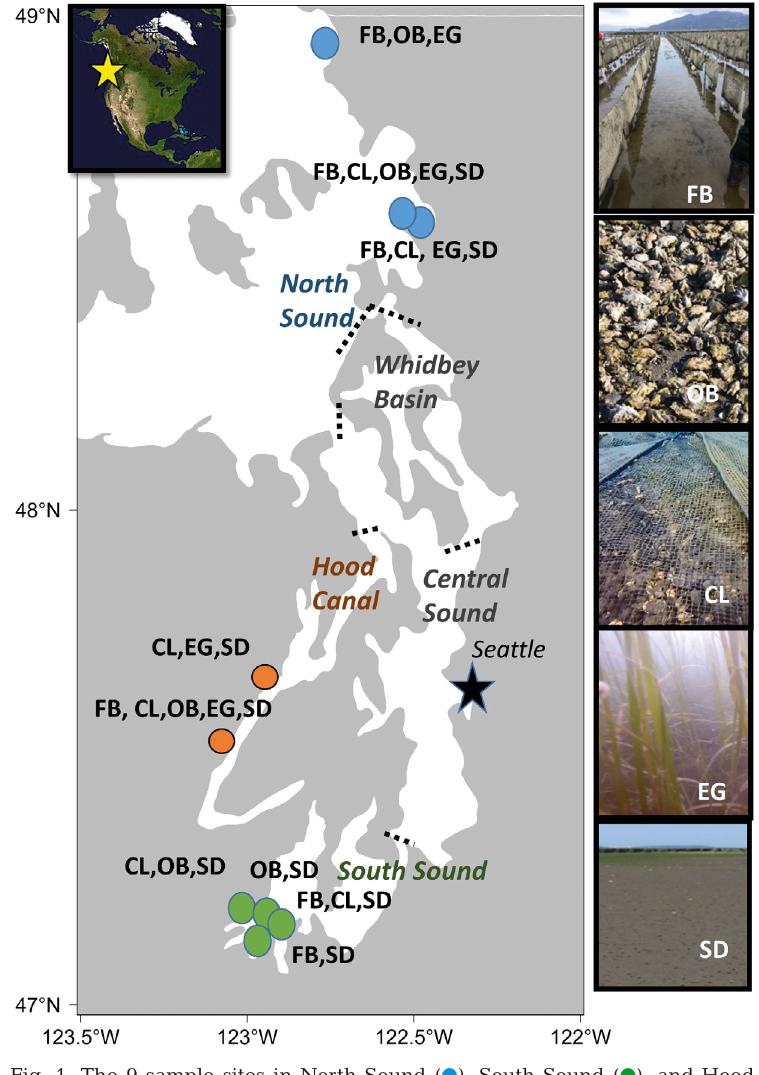
Fig. 1. The 9 sample sites in North Sound ( d ), South Sound ( d ), and Hood Canal ( d ), Puget Sound, Washington, USA. The 5 natural basins are labelled with their boundaries marked by dashed black lines. Photos show the 5 meso- habitat types sampled, including: Pacific oyster in flipbags (FB), Pacific oysters on-bottom (OB), Manila clams (CL), uncultured eelgrass (EG), and uncultured sediment